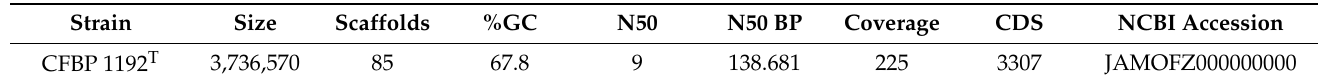
Table 3. Features of the complete genome sequence of CFBP 1192 T , type strain of Xylophilus ampelinus